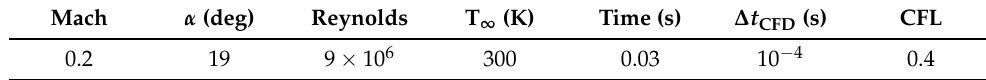
Table 2. The 30P30N simulation